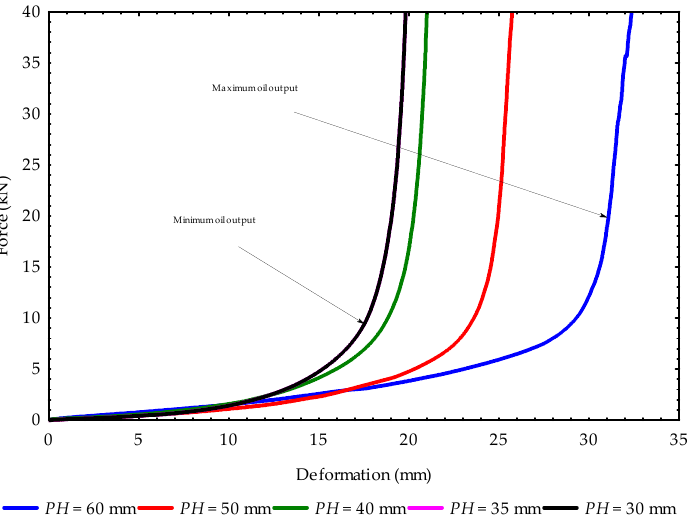
Figure 3. Force–deformation curves of hulled sunflower seed oil extraction at repeated pressings for the control temperature of 24 ◦ C ( PH = 60 mm is the initial pressing height) represent the temperatures of 40, 60 and 80 °C for maximum oil output. The pink curve is under the black curve.